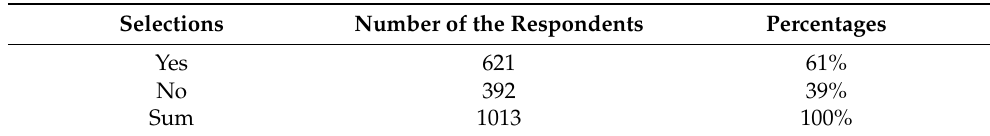
Table A15. Do you think that the distribution ledger in blockchain will become a trend and substitute the central ledger in the future (single-choice question)?